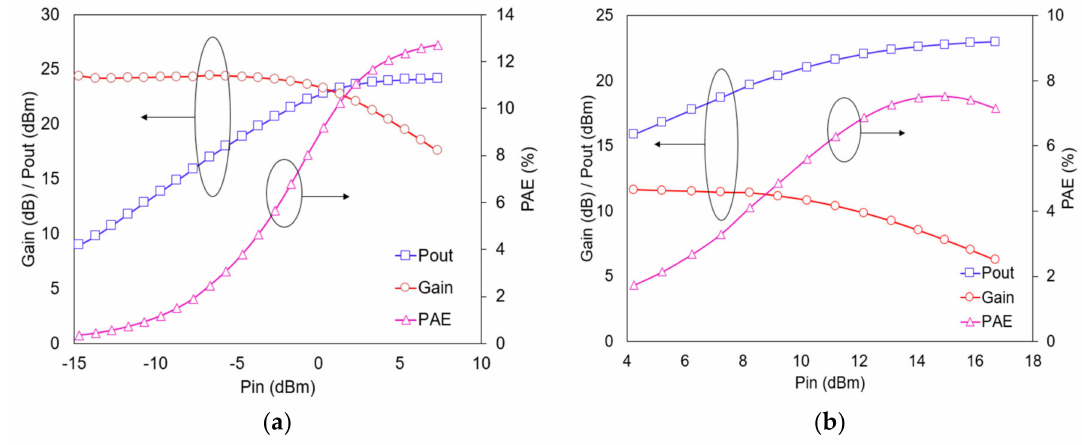
Figure 11. Gain, P out , and PAE of the proposed PA according to input power at ( a ) 32 GHz and ( b ) 47